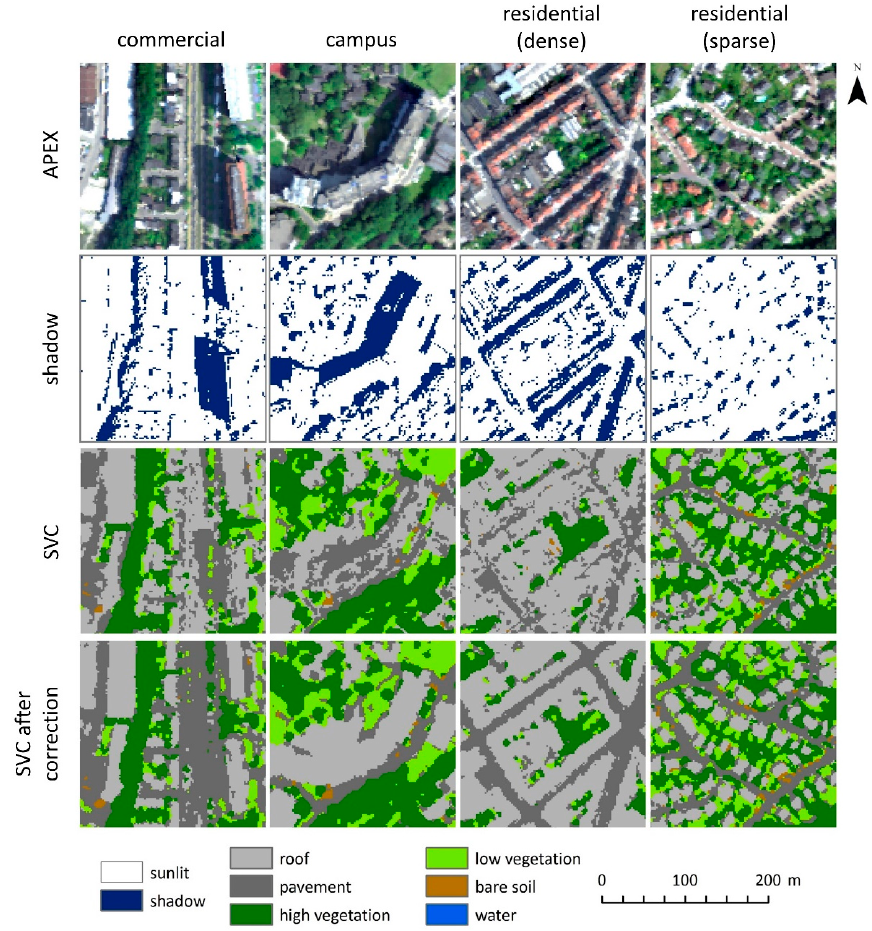
Figure 8. Illustration of level 1 mapping results of Support Vector Classification (third row) and LiDAR post-classification correction (fourth row) for a selection of subsets representing different urban typologies (commercial-light industry, university campus, dense residential and sparse residential) present in the image scene. The RGB APEX image (first row) and the hybrid shadow mask (second row) have been included in this figure as visual reference.